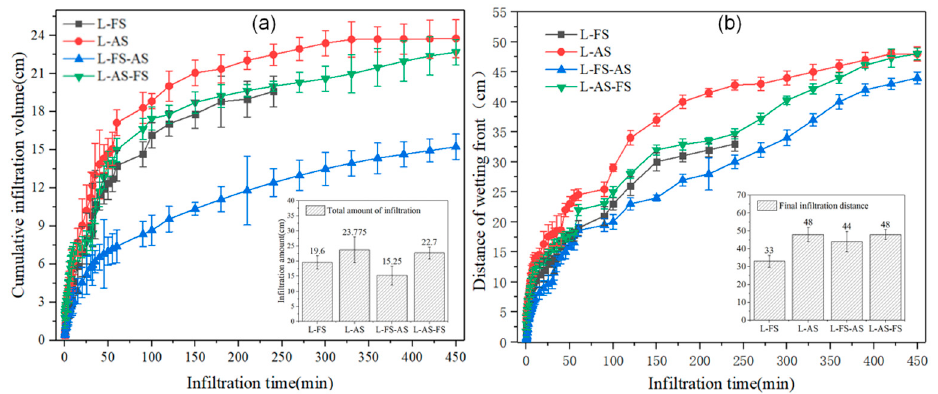
Figure 4. Vertical water infiltration volume and change of the wetting front. ( a ) is the change in